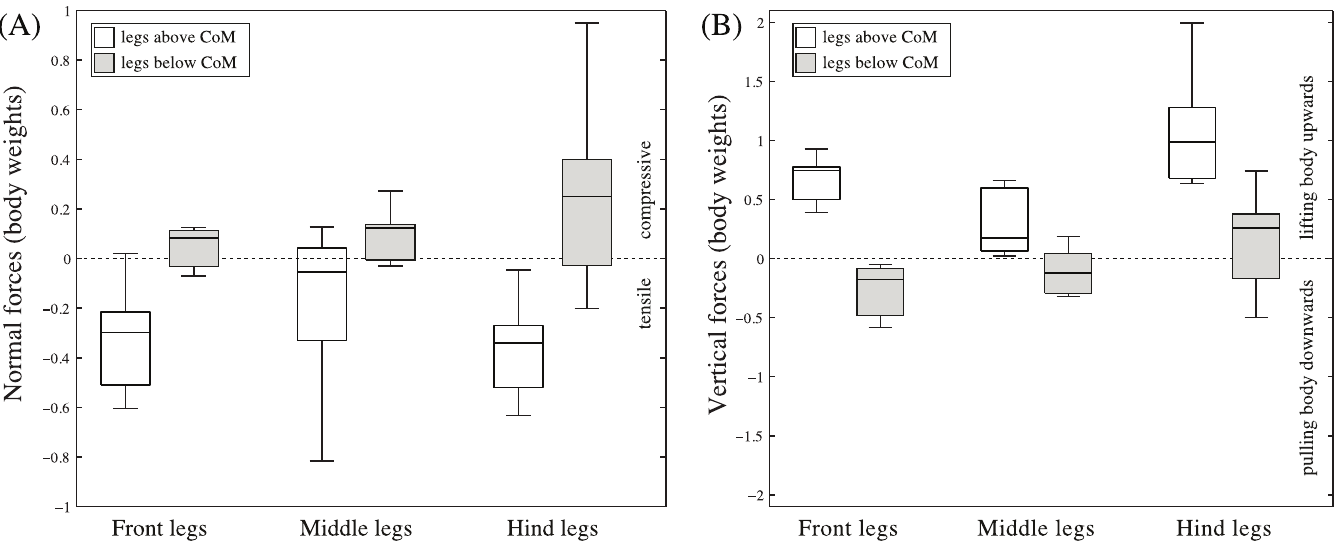
Fig 3. Ground reaction forces in vertically climbing weaver ants. (A) normal forces. (B) vertical forces (number of legs above (below) CoM: N front = 9(3); N middle = 10(8); N hind =